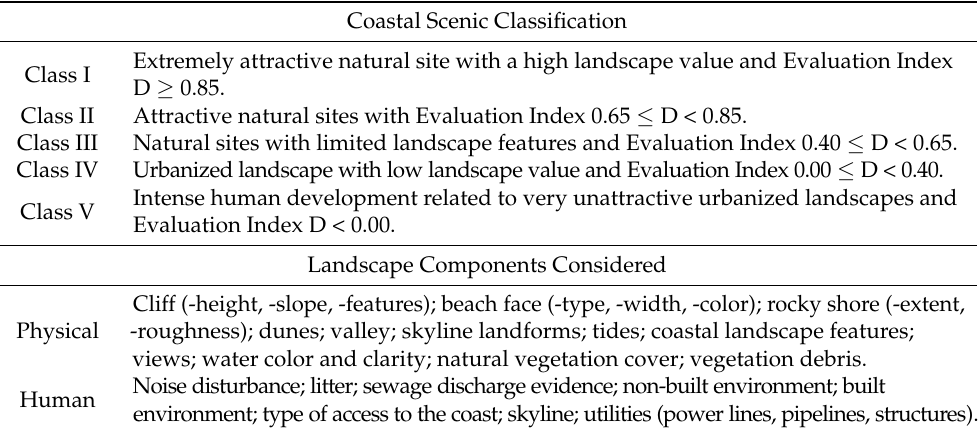
Table 1. Coastal scenic classification and landscape components according to the methodology described in [53].